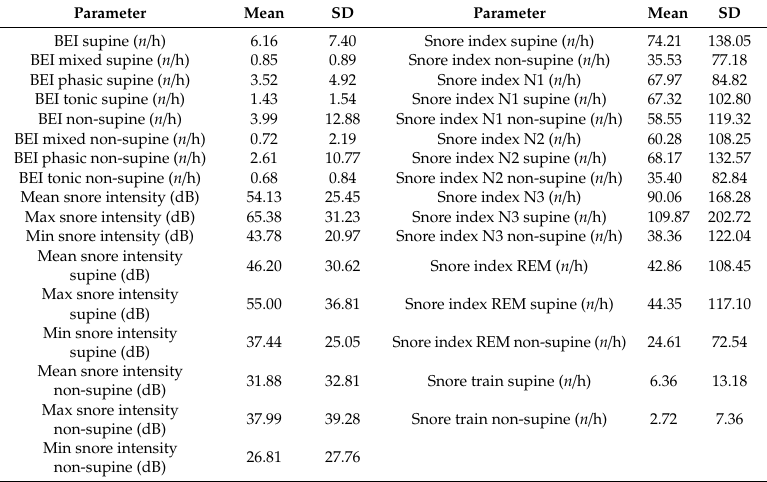
Table 2. Mean bruxism and snore parameters di ff erentiated on the basis of body position. Parameter